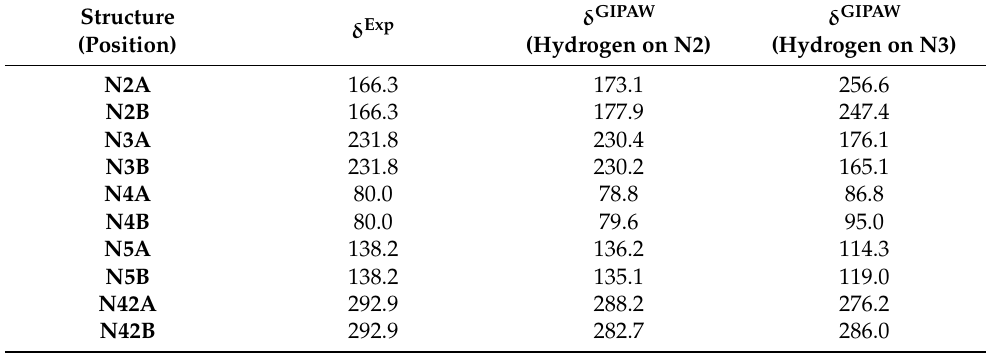
Figure 14. 15 N CP MAS NMR spectra of compound 1 ( a ) and compound 4 ( b ), recorded at a spinning rate of 8 kHz and 1 H Larmor frequency of 400.1 MHz at ambient temperature. Assignments are colored blue and indicate –N = NH- positions by green rectangles. Table 9. 15 N CP MAS NMR experimental and GIPAW calculated chemical shifts ( δ ) [in ppm] (recalculated from GIPAW nuclear shieldings from equation δ = 230 − σ GIPAW ) for compound 1 with the hydrogen attached to the nitrogen in position N2 or N3 in the crystal